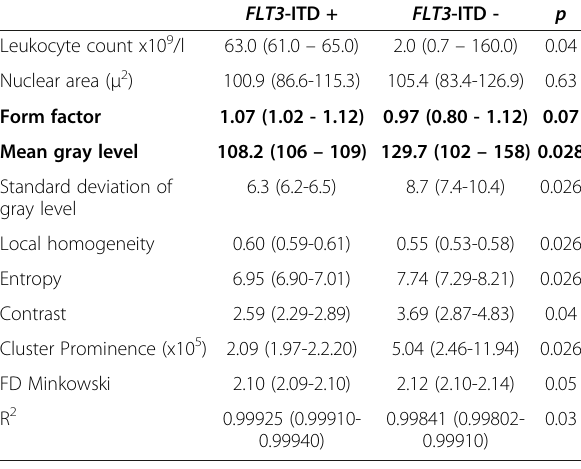
Table 6 Morphometric features of patients with APL according to FLT3 -ITD